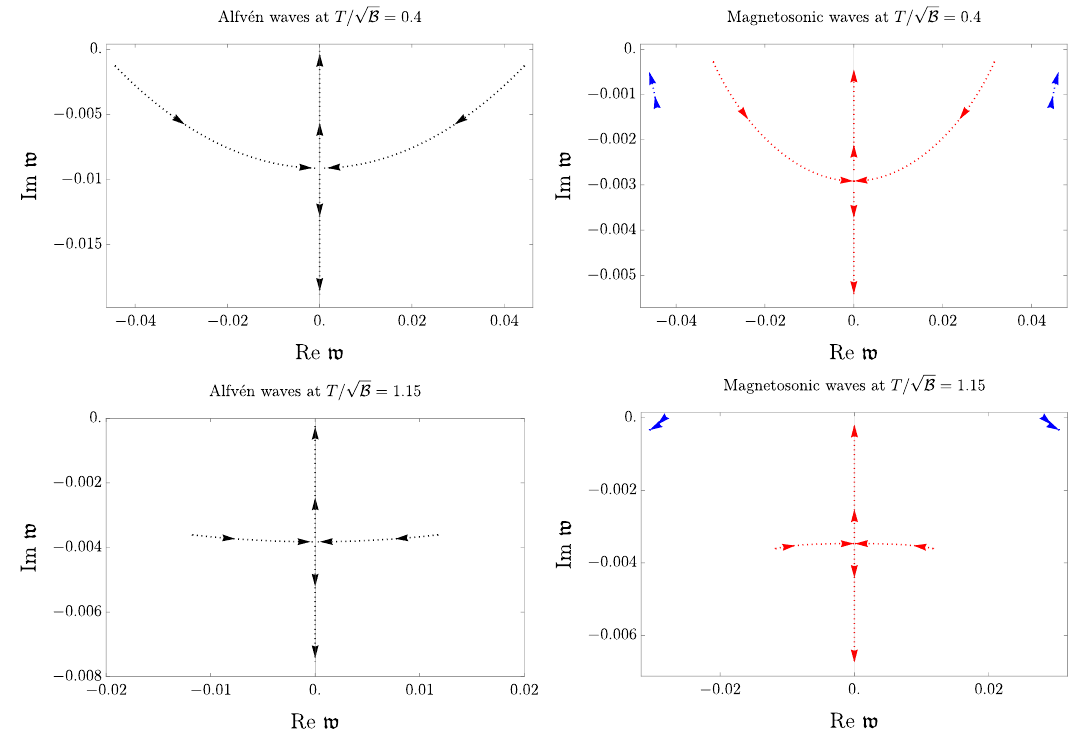
p Figure 7 . Dependence of the complex (dimensionless) frequency w = != B on (cid:18) , plotted for Alf(cid:19)en (black) and fast (blue) and slow (red) magnetosonic waves in the strong- and weak-(cid:12)eld regimes p p with T= B = 0 : 4 and T= B = 1 : 15, respectively. The arrows represent the motion of poles as (cid:18) is p tuned from 0 to (cid:25)= 2. Momentum is set to k= B = 0 :